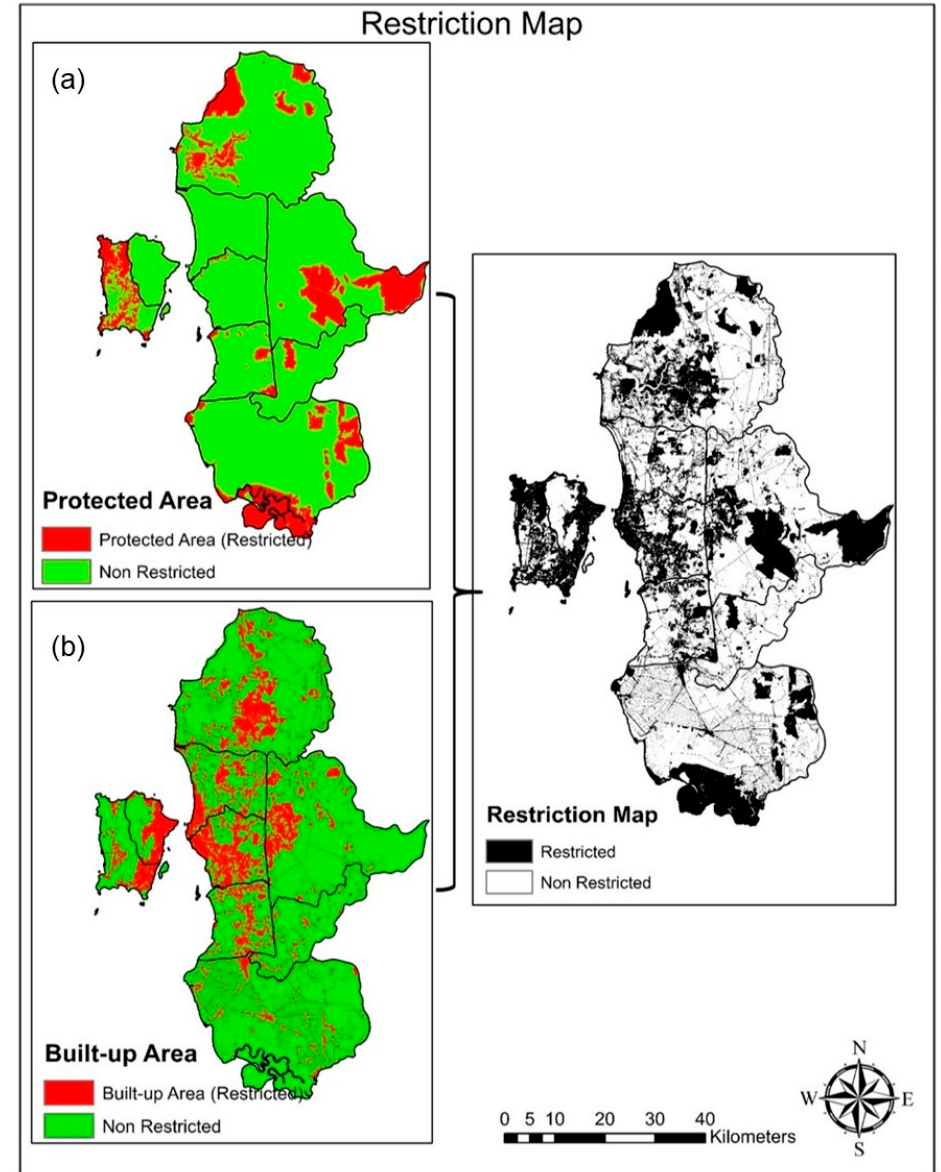
Figure 7. Restriction map generated from ( a ) protected area and ( b ) built-up area.